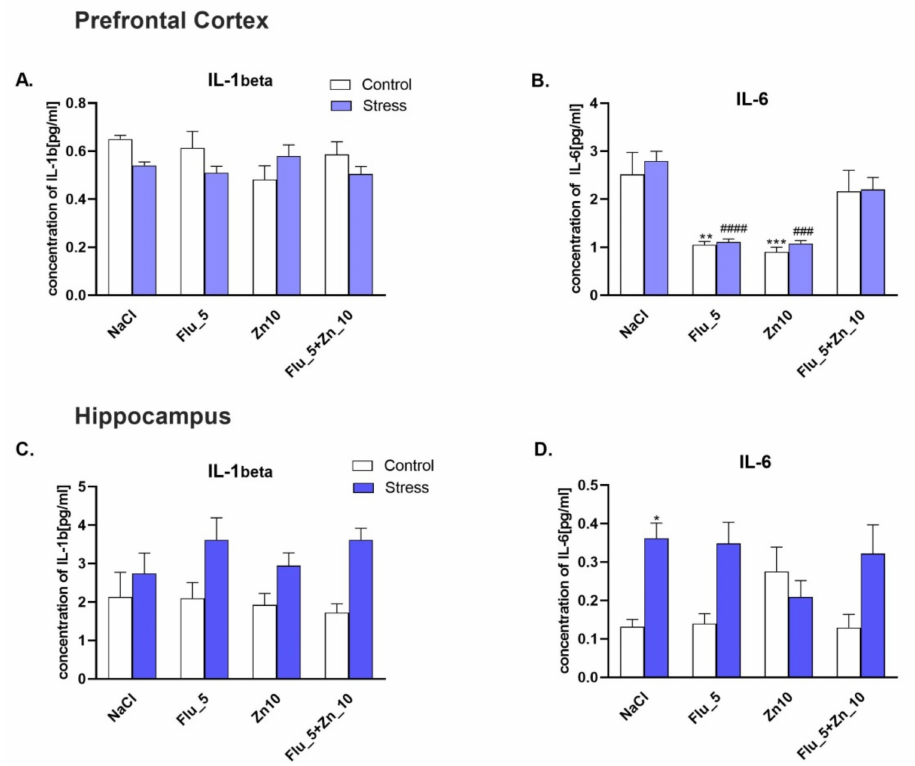
Figure 7. The effect of Zn supplementation and FLU treatment on the concentration of IL-1beta ( A , C ) and IL-6 ( B , D ) in the PFC and Hp of mice subjected to CRS. All data were analyzed by two-way ANOVA and Newman–Keuls multiple comparison test. Values are expressed as mean ± SEM; n = 6–8. * p < 0.05; ** p < 0.01; *** p < 0.001 vs. NaCl; ### p < 0.001; #### p < 0.0001 vs. CRS +